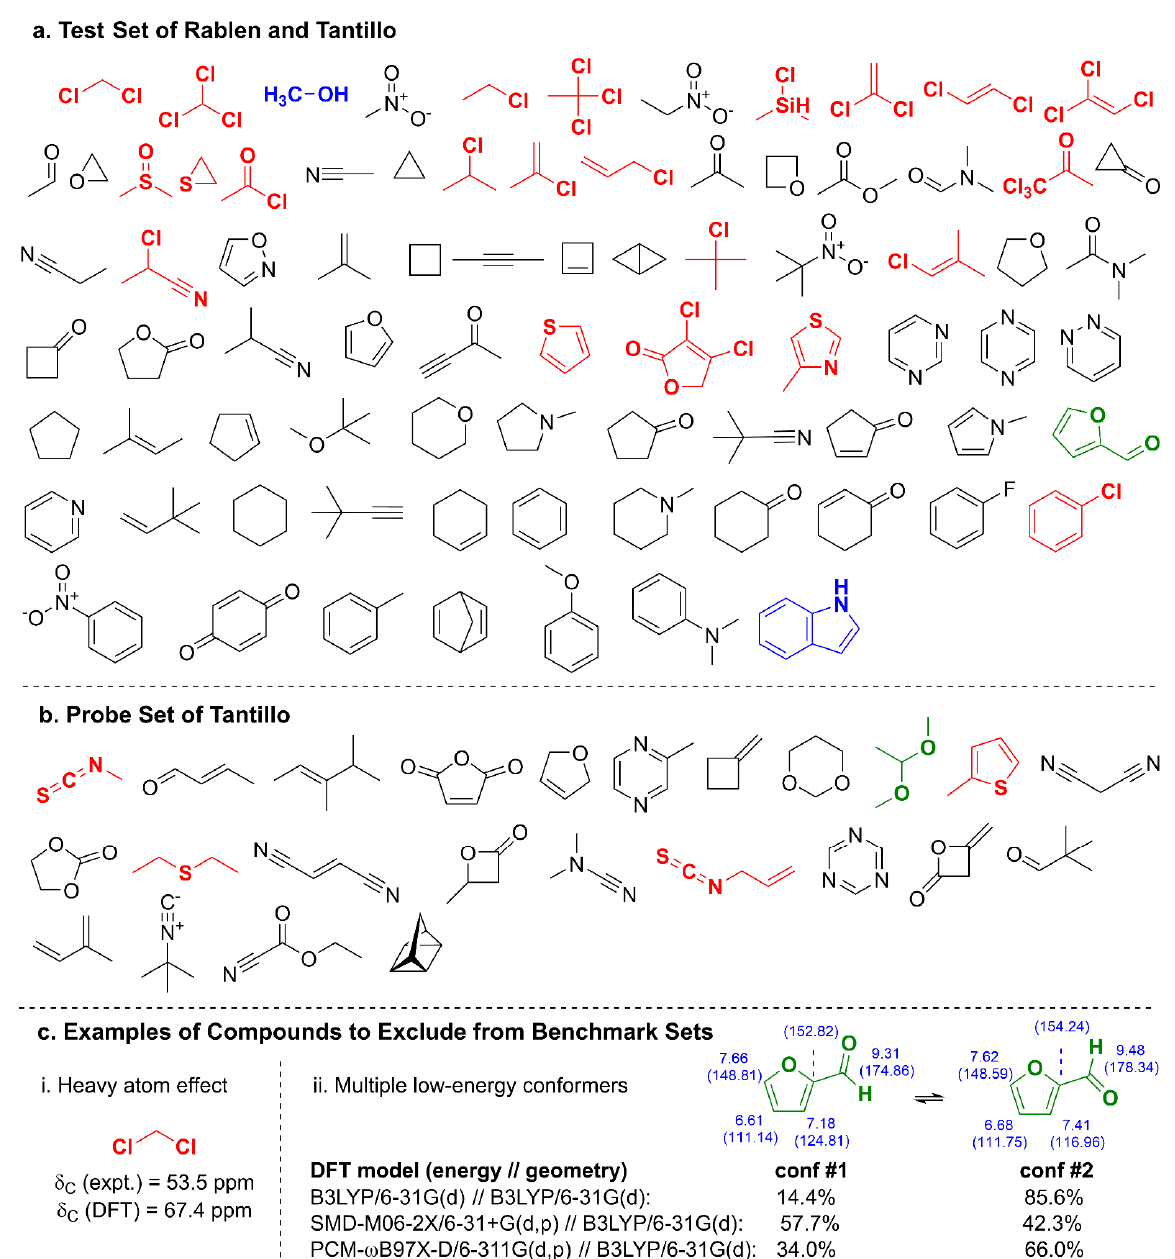
Figure 1. ( a ) Benchmark test set used by Rablen et al. [1] and Tantillo et al. [3] to generate linear scaling factors per Equation (1). Bold-faced, colored structures are modeling challenges due to row three atoms (red), H-bond donors (blue), or multiple low-energy conformers (green). ( b ) Probe set used by Tantillo et al. [3] to examine accuracy of DFT model chemistries for δ H and δ C predictions. ( c ) Examples of problematic structures for benchmarking: (i) attachment of Cl, a row three heavy atom, to carbon results in a 13.9 ppm δ C overprediction by DFT; and (ii) difficulties with accurately determining conformer energetics, as shown for several different energy calculations both with and without dispersion corrections using the same B3LYP/6-31G(d) geometries, can lead to vastly different Boltzmann populations and chemical shift predictions. Both 1 H and 13 C chemical shifts ( δ C in parentheses) were calculated using the DP4+ model (PCM-mPW1PW91/6-31+G**//B3LYP/6-31G*) [82].